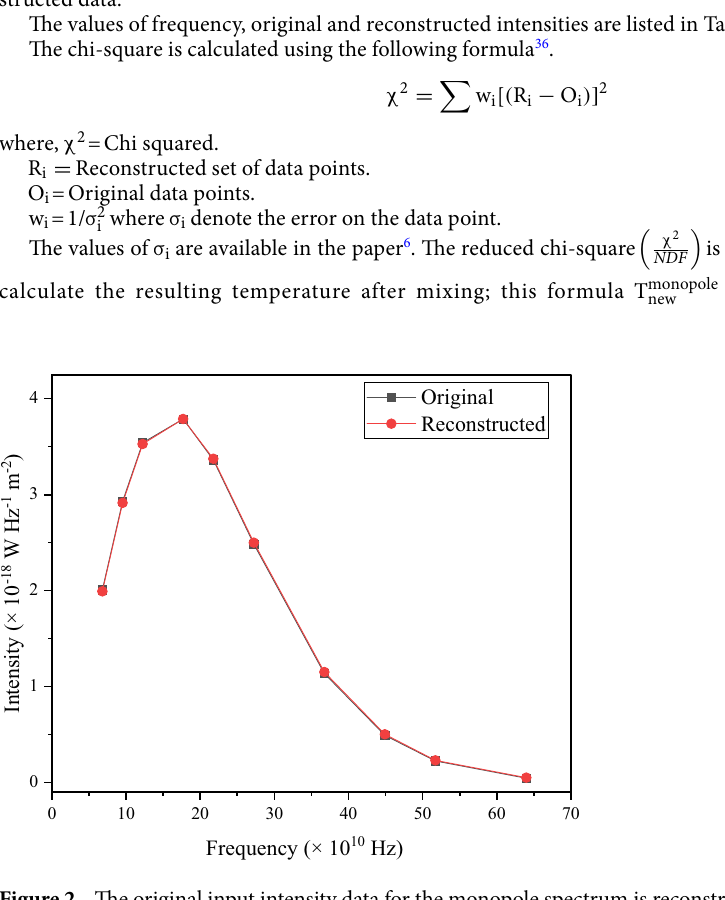
Figure 2. The original input intensity data for the monopole spectrum is reconstructed using the obtained probability distribution of temperature α m (T). Plots of experimental and reconstructed intensities versus frequency are shown. The figure shows a close resemblance between the reconstructed data and the original